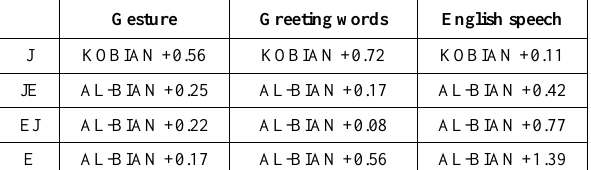
Table 4. Differences in preference of greeting due to verbal and non-verbal channels.